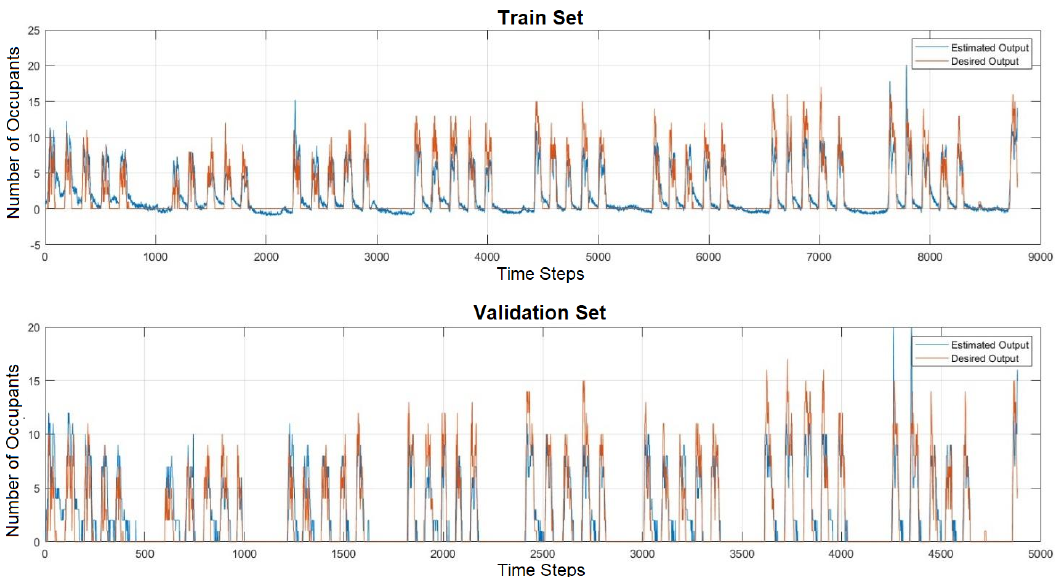
Figure 12. DE-OSELM occupancy prediction results, when the variables’ data set consists of indoor parameters: T in , RH in , CO 2.